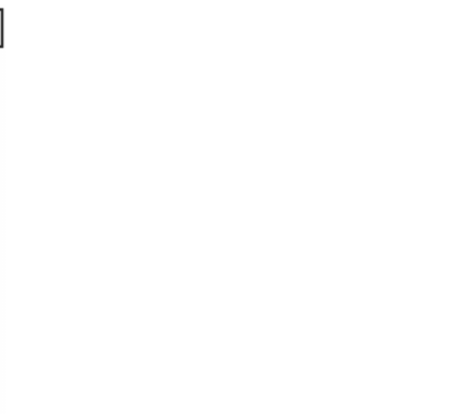
Figure 7. Comparison of system response with an original sized crack and a double sized crack at 50% offset (A1O50S).